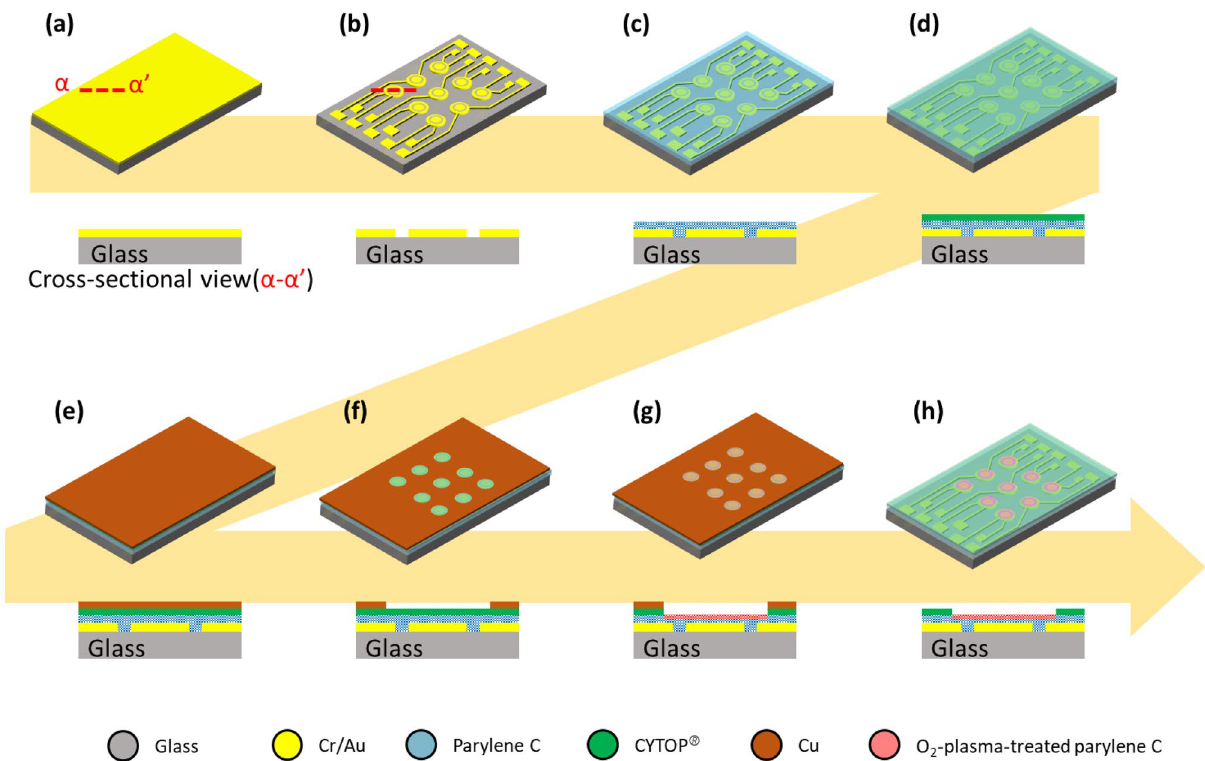
Figure 9. Fabrication process of hydrophilic–hydrophobic patterns above electrodes for EWOD. Cross- sectional drawings along the red dotted lines are also presented. ( a ) Deposition of Cr (70 nm thick) and Au (200 nm thick) on a glass substrate. ( b ) Patterning of circular patterns of elemental electrodes composed of center and outer electrodes. ( c ) Deposition of 1 μm thick parylene C as an insulating layer on the substrate. ( d ) Coating of a 12 nm thick CYTOP ® layer as a hydrophobic layer. ( e ) Evaporation of the Cu layer on the CYTOP ® layer. ( f ) Patterning of Cu for opening of circular patterns of CYTOP ® . ( g ) O 2 -plasma-etching of CYTOP